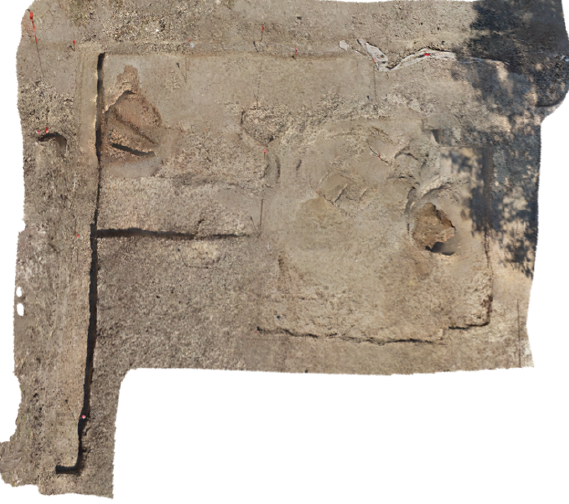
Figure 4: elevation model by CRP and TLS surveying (excava- tion campaign 2013)